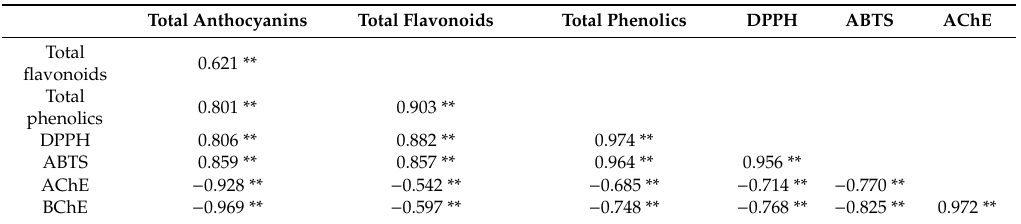
Table 4. Pearson correlation ( R ) between antioxidant compounds, antioxidant activities, and AChE and BChE inhibitory activity of blueberry fruits. Total Anthocyanins Total Flavonoids Total